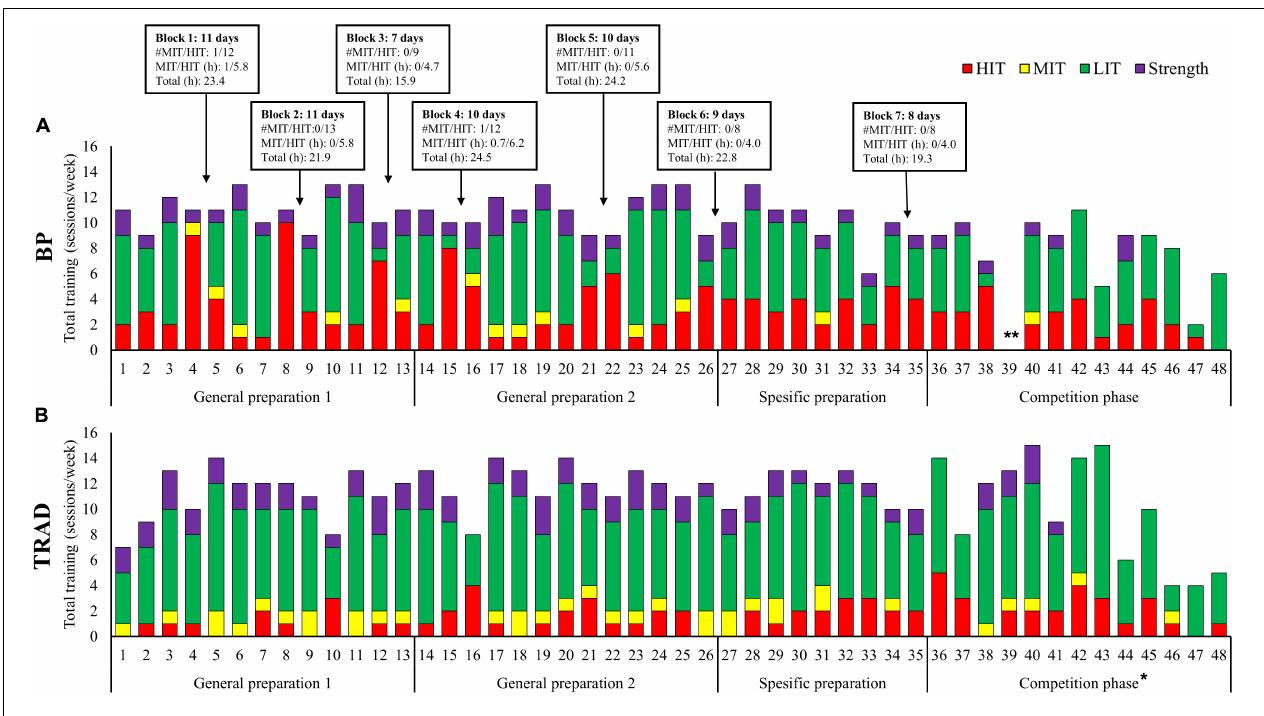
FIGURE 2 | The placement of high-intensity training blocks and the weekly training sessions distributed into endurance training [low (LIT), moderate (MIT), high-intensity (HIT]) and strength training across the annual cycle using block periodization of HIT (BP) (A) , and the season using traditional periodization (TRAD) (B) . ∗ The competition phase, includes many short duration LIT sessions (i.e., morning jogs or restitution sessions before and after competitions). ∗∗ Week 39 in BP, contains no training since the participant was sick.